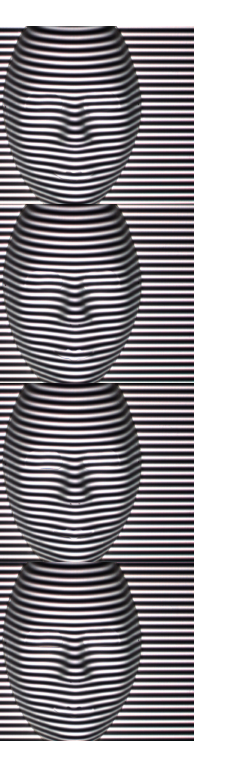
Figure 5. Experimental setup. ( a ) A general view of the setup; ( b ) the digital light processor (DLP) and the CCD camera used in the experiments.